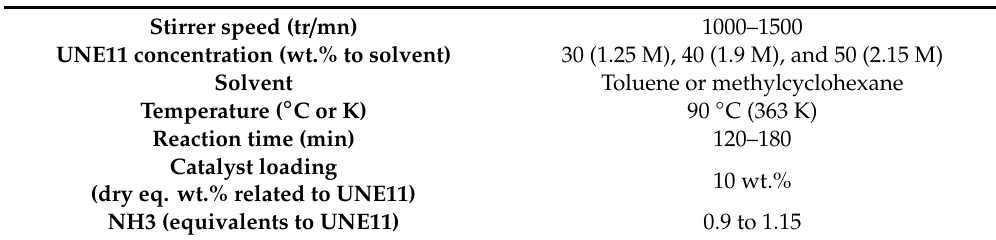
Table 13. Reaction